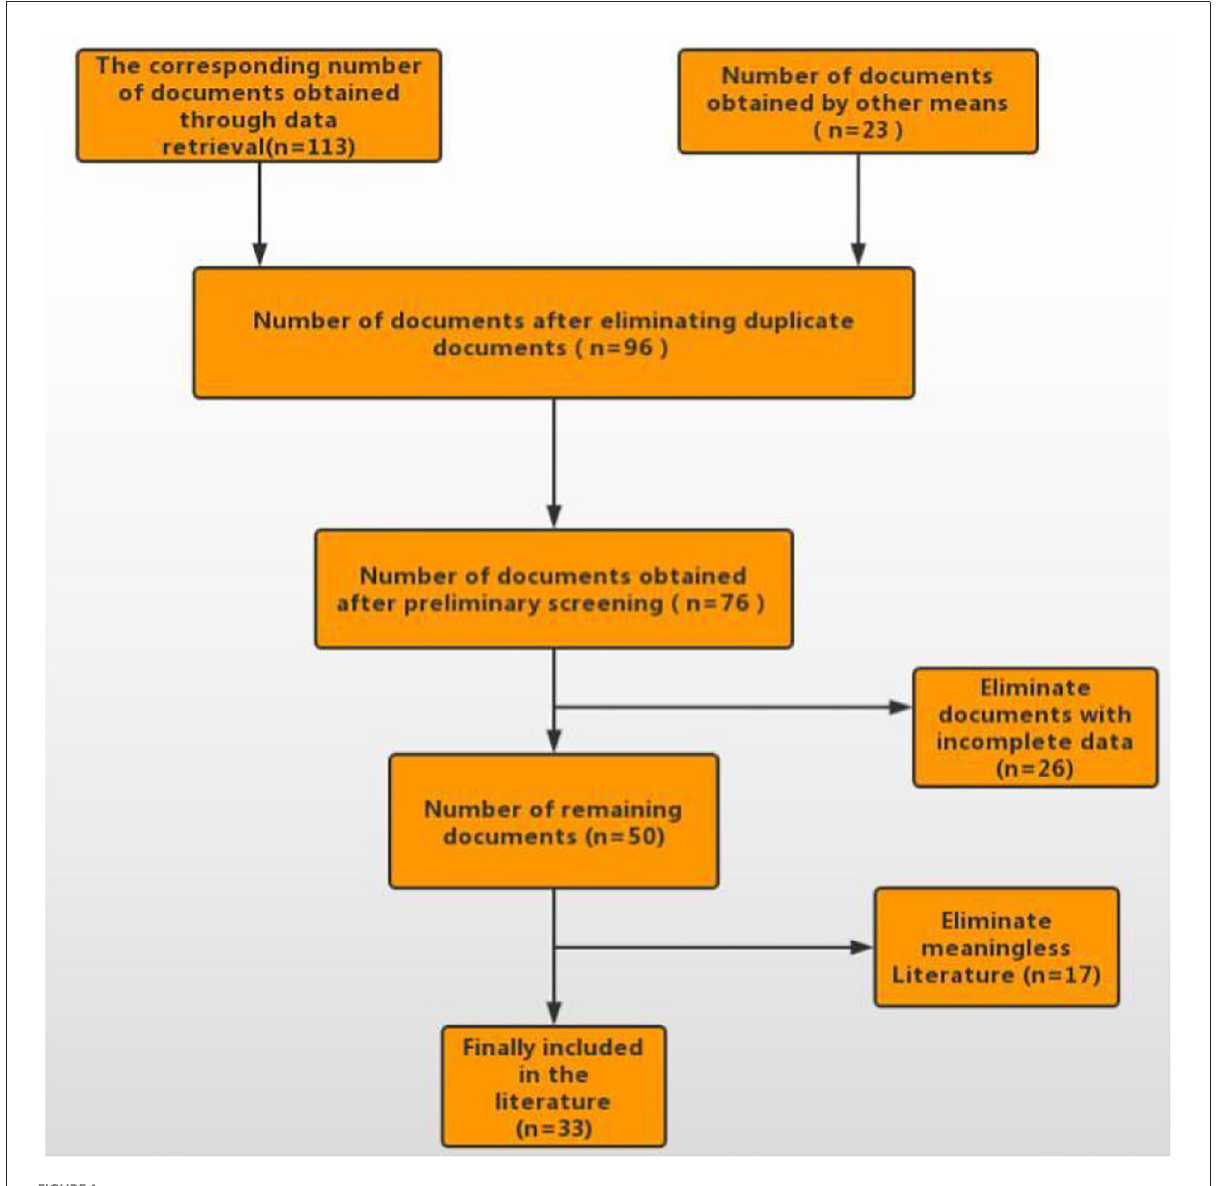
FIGURE1 Mesh meta-analysis flow